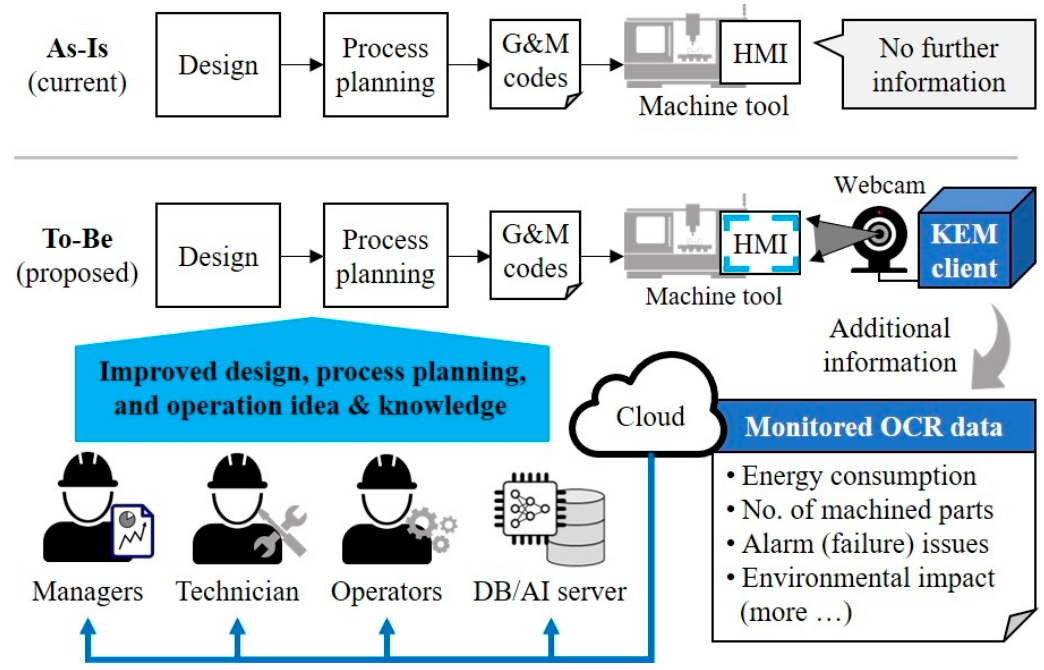
Sensors 2019 , 19 , x 8 of 18